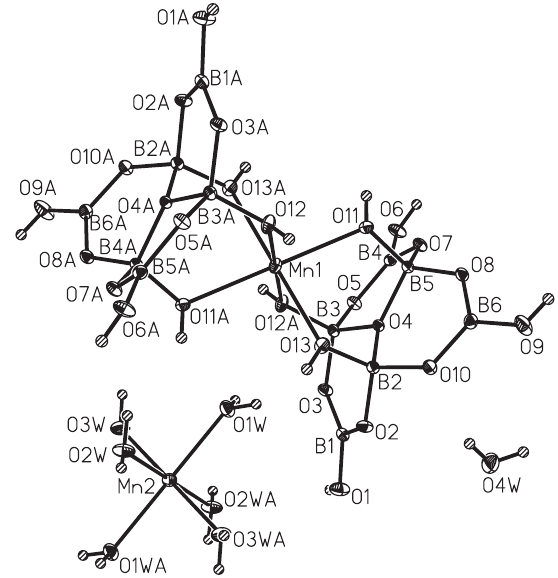
Figure: The molecular structure of the title compound showing 30° displacement ellipsoids.